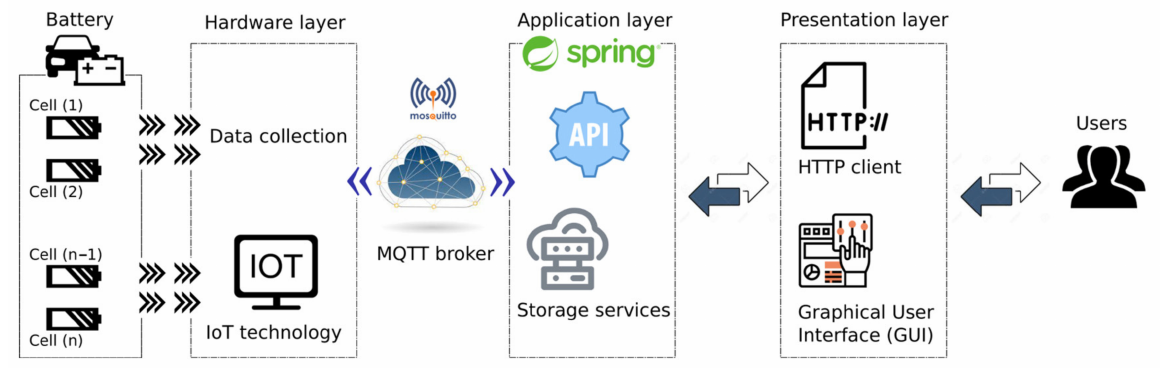
Figure 1. System architecture and its